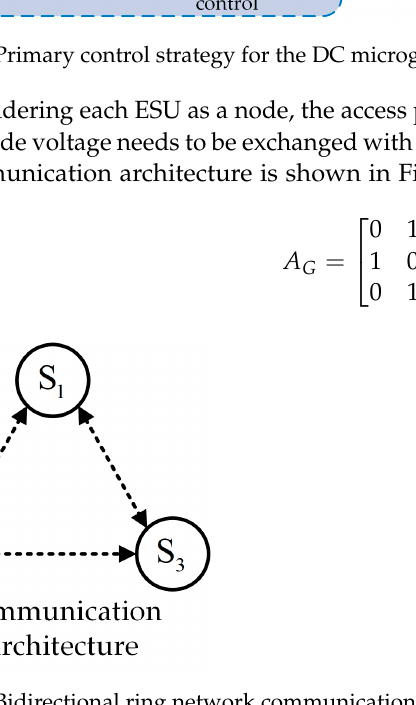
Figure 11. Bidirectional ring network communication structure for the DC microgrid with ESSs.